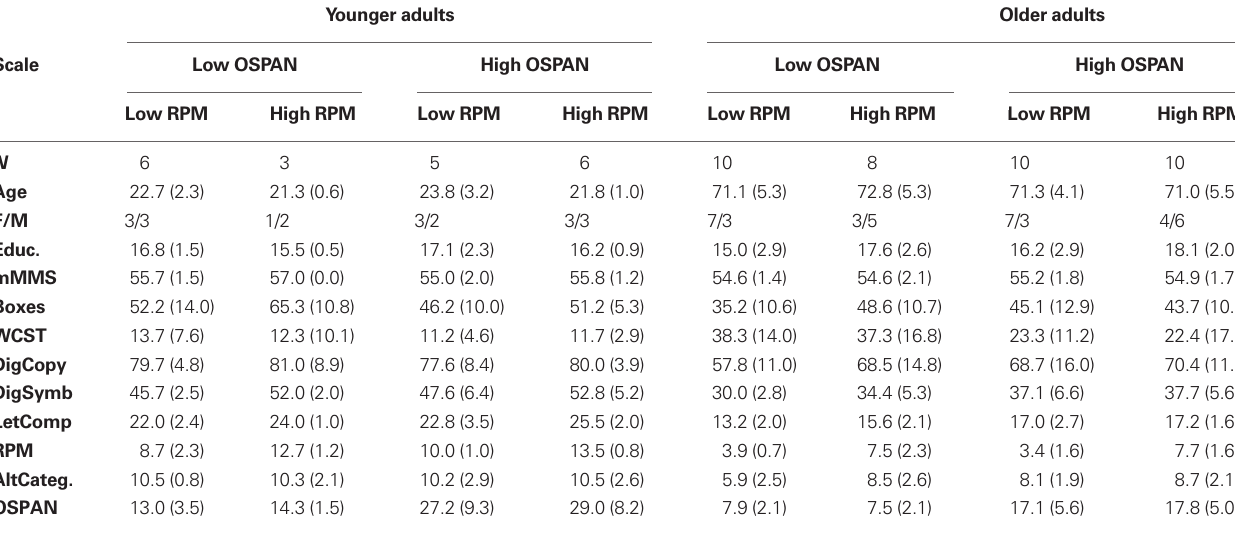
Table 1 | Demographic and neuropsychological data for each group in the study: mean (SD).